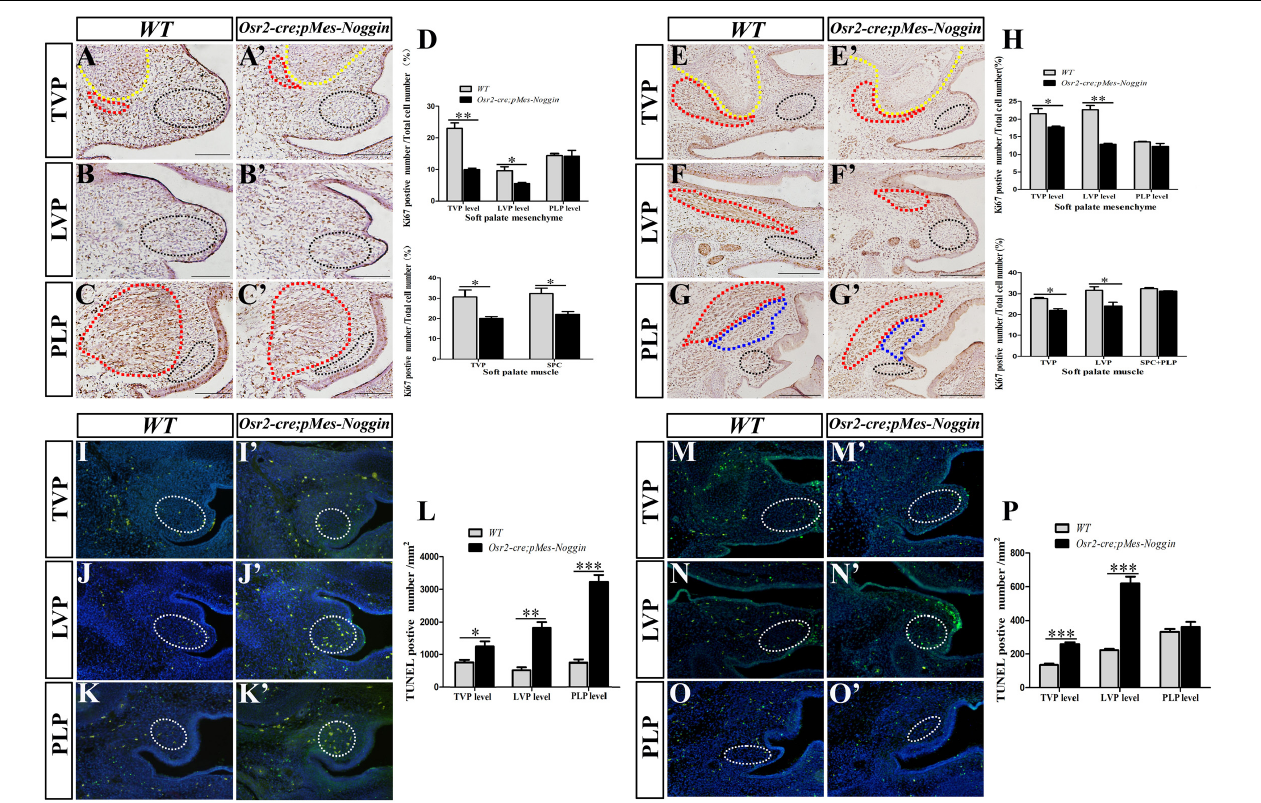
FIGURE 3 | Ki67 immunostaining and TUNEL assay in Osr2-cre KI ;pMes-Noggin soft palates. (A,A (cid:48) –C,C (cid:48) ) The immunostaining of Ki67 in the E13.5 WT soft palate at the TVP (A) , LVP (B) , and PLP (C) levels, and the E13.5 Osr2-cre KI ;pMes-Noggin soft palates at the TVP (A (cid:48) ) , LVP (B (cid:48) ) , and PLP (C (cid:48) ) levels. The yellow and red dotted lines in (A,A (cid:48) ) delineate the boundary of HPPs and TVPs, respectively. The red dotted lines in (C,C (cid:48) ) delineate the SPCs. The black dotted circles in (A,A (cid:48) –C,C (cid:48) ) delineate the mesenchymal areas for Ki67-positive cell counting. (D) Statistical assay for the Ki67 percentages in the TVP and SPC myofibers, and mesenchyme in the E13.5 WT and Osr2-cre KI ;pMes-Noggin soft palates. Student’s t -test showed that the Ki67 percentages in the E13.5 WT TVP (30.71% ± 5.59%) were higher than those in the Osr2-cre KI ;pMes-Noggin TVP (20.04% ± 1.56%, p = 0.0335); the Ki67 percentages in the E13.5 WT SPC (32.46% ± 4.18%) were higher than those in the Osr2-cre KI ;pMes-Noggin SPC (22.07% ± 2.39%, p = 0.0202); the Ki67 percentages in the E13.5 WT TVP mesenchyme (23.08% ± 3.09%) were higher than those in the Osr2-cre KI ;pMes-Noggin TVP mesenchyme (9.95% ± 0.85%, p = 0.0019); the Ki67 percentages in the E13.5 WT LVP mesenchyme (9.615% ± 2.192%) were higher than those in the Osr2-cre KI ;pMes-Noggin LVP mesenchyme (5.52% ± 0.604%, p = 0.0355); the Ki67 percentages in the E13.5 WT PLP mesenchyme (14.47% ± 0.936%) were comparable with those in the Osr2-cre KI ;pMes-Noggin PLP mesenchyme (14.28% ± 3.104%, p = 0.92108) (four E13.5 Osr2-cre KI ;pMes-Noggin embryos and their WT littermates were collected for statistical assay). (E,E (cid:48) –G,G (cid:48) ) The immunostaining of Ki67 in the E14.5 WT soft palate at the TVP (E) , LVP (F) , and PLP (G (cid:48) ) levels, and the E14.5 Osr2-cre KI ;pMes-Noggin soft palates at the TVP (E (cid:48) ) , LVP (F (cid:48) ) , and PLP (G (cid:48) ) levels. The yellow and red dotted lines in (E , E (cid:48) ) delineate the boundary of HPPs and TVPs, respectively. The red dotted lines in (F,F (cid:48) ) delineate the LVPs. The red dotted lines in (G,G (cid:48) ) delineate the SPCs. The blue dotted lines in (G , G (cid:48) ) circle PLPs. The black dotted circles in (E,E (cid:48) –G,G (cid:48) ) delineate the mesenchymal areas for Ki67-positive cell counting. (H) Statistical assay for the Ki67 percentages in the TVP, LVP, SPC, and PLP myofibers and mesenchyme in the E14.5 WT and Osr2-cre KI ;pMes-Noggin soft palates. Student’s t -test showed that the Ki67 percentages in the E14.5 WT TVP (27.90% ± 0.563%) were higher than those in the Osr2-cre KI ;pMes-Noggin TVP (23.74% ± 3.765%, p = 0.0025); the Ki67 percentages in the E14.5 WT LVP (35.95% ± 9.36%) were higher than those in the Osr2-cre KI ;pMes-Noggin SPC (25.69% ± 4.21%, p = 0.04357); the Ki67 percentages in the E14.5 WT SPC and PLP (31.67% ± 1.362%) were indistinguishable from those in the Osr2-cre KI ;pMes-Noggin SPC and PLP (30.71% ± 0.78%, p = 0.2561); the Ki67 percentages in the E14.5 WT TVP mesenchyme (23.55% ± 4.16%) were higher than those in the Osr2-cre KI ;pMes-Noggin TVP mesenchyme (18.49% ± 1.466%, p = 0.0121); the Ki67 percentages in the E14.5 WT LVP mesenchyme (21.03% ± 3.725%) were higher than those in the Osr2-cre KI ;pMes-Noggin LVP mesenchyme (13.19% ± 0.844%, p = 0.00638); the Ki67 percentages in E14.5 WT PLP mesenchyme (14.52% ± 2.06%) were similar to those in the Osr2-cre KI ;pMes-Noggin PLP mesenchyme (12.72% ± 1.654%, p = 0.22456). Five E14.5 Osr2-cre KI ;pMes-Noggin embryos and their WT littermates were collected for statistical assay. (I,I (cid:48) –K,K (cid:48) ) The TUNEL assay in the E13.5 WT soft palate at the TVP (I) , LVP (J) , and PLP (K) levels, and the E13.5 Osr2-cre KI ;pMes-Noggin soft palates at the TVP (I (cid:48) ) , LVP (J (cid:48) ) , and PLP (K (cid:48) ) levels. The white dotted circles in (I,I (cid:48) –K,K (cid:48) ) mean the areas for TUNEL-positive cell counting. (L) Statistical assay for the TUNEL densities in the E13.5 WT and Osr2-cre KI ;pMes-Noggin soft palates at the TVP, LVP, and PLP levels. Student’s t -test showed that the TUNEL densities in the E13.5 WT TVP level (754.29 ± 139.14 cells/mm 2 ) were much lower than those in the Osr2-cre KI ;pMes-Noggin TVP level (1,251.18 ± 269.98 cells/mm 2 , p = 0.0472); the TUNEL densities in the E13.5 WT LVP level (526.23 ± 155.39 cells/mm 2 ) were lower than those in the Osr2-cre KI ;pMes-Noggin LVP level (1,823.57 ± 309.96 cells/mm 2 , p = 0.00292); the TUNEL densities in the E13.5 WT PLP level (746.05 ± 8.01 cells/mm 2 ) were lower than those in the Osr2-cre KI ;pMes-Noggin PLP level (3,332.16 ± 366.88 cells/mm 2 , p = 0.000435). Three E13.5 Osr2-cre KI ;pMes-Noggin embryos and their WT littermates were collected for statistical assay. (M,M (cid:48) –O,O (cid:48) ) The TUNEL assay in the E14.5 WT soft palate at the TVP (M) , LVP (N) , and PLP (O) levels, and the E13.5 Osr2-cre KI ;pMes-Noggin soft palates at the TVP (M (cid:48) ) , LVP, (N (cid:48) ) and PLP (O (cid:48) ) (Continued)